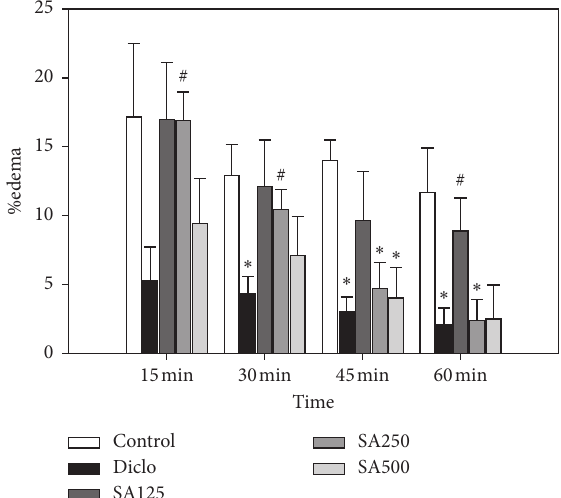
Figure 1: Percentage ear edema induced by xylene at 15, 30, 45, and